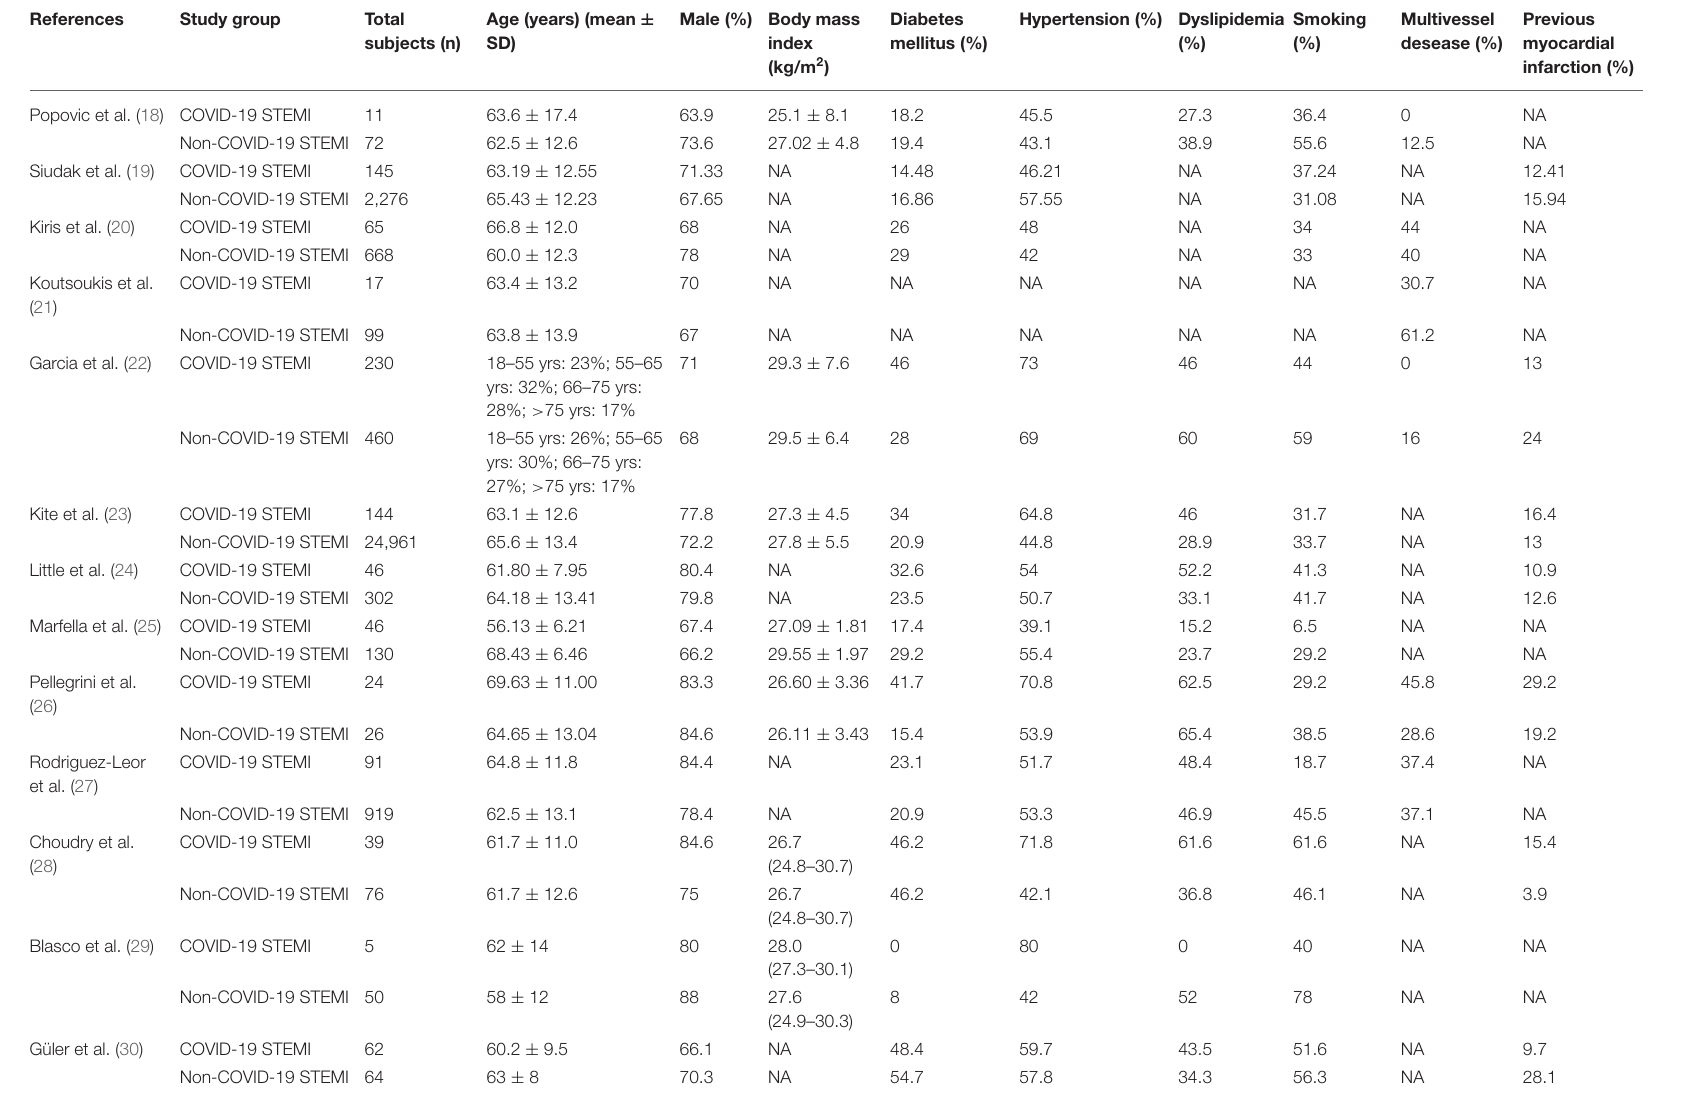
TABLE 2B | Baseline characteristics of study